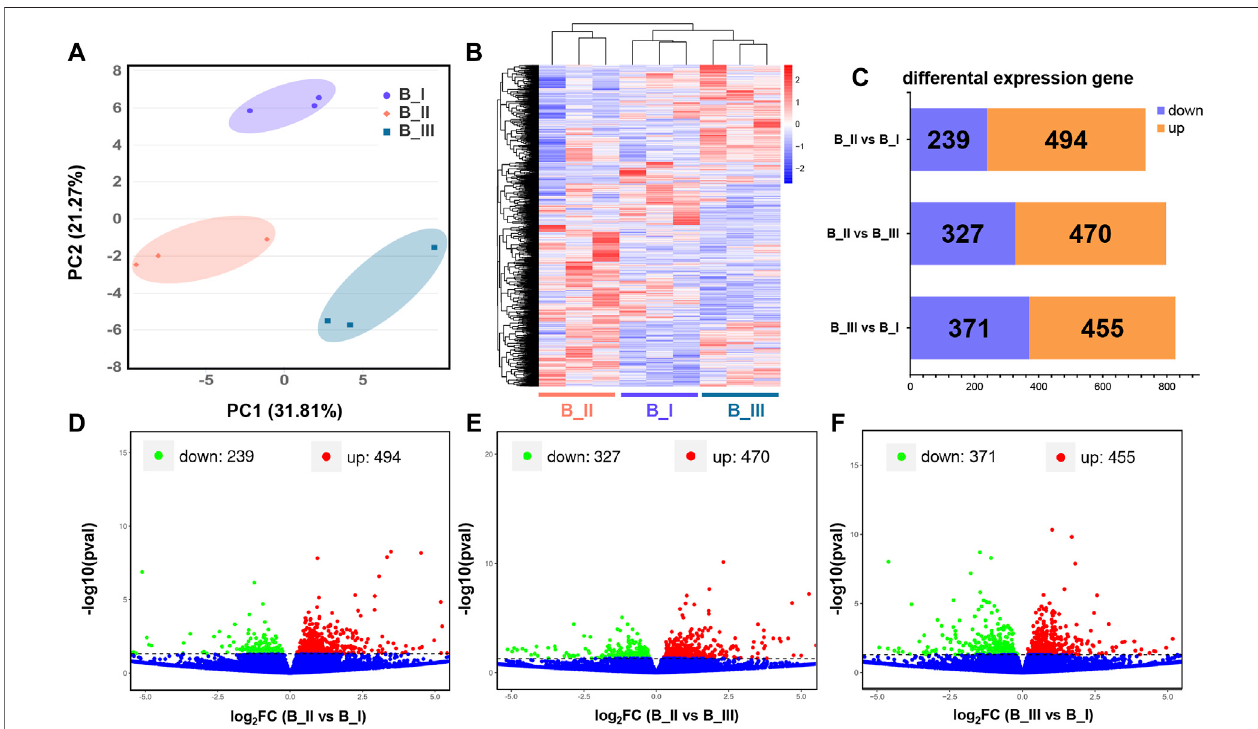
FIGURE 1 | Transcriptional pro fi les in the brain of black rock fi sh parturition. Principal component analysis (PCA) (A) and heatmap (B) of different expression gene (DEG) function clustering of black rock fi sh brain before parturition (B_I), during parturition (B_II), and 24 h after parturition (B_III). Bar plot (C) and volcano plots represented the DEGs in B_II vs. B_I group (D) , B_II vs. B_III group (E) , and B_III vs. B_I group (F) ,